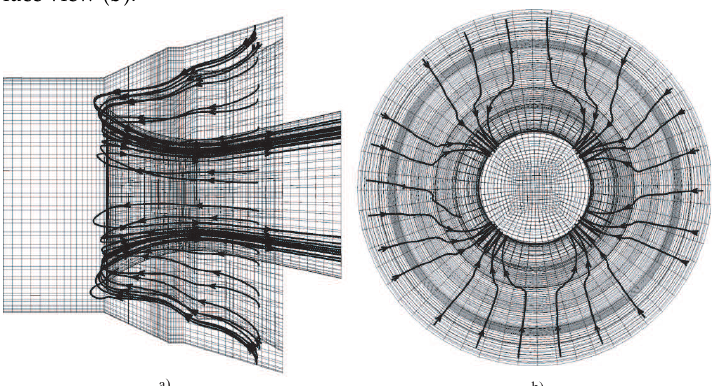
Figure 18. Streamlines near the rear nozzle head for star-shaped channel ( α = 0 ◦ ): side view ( a ) and face view ( b ).